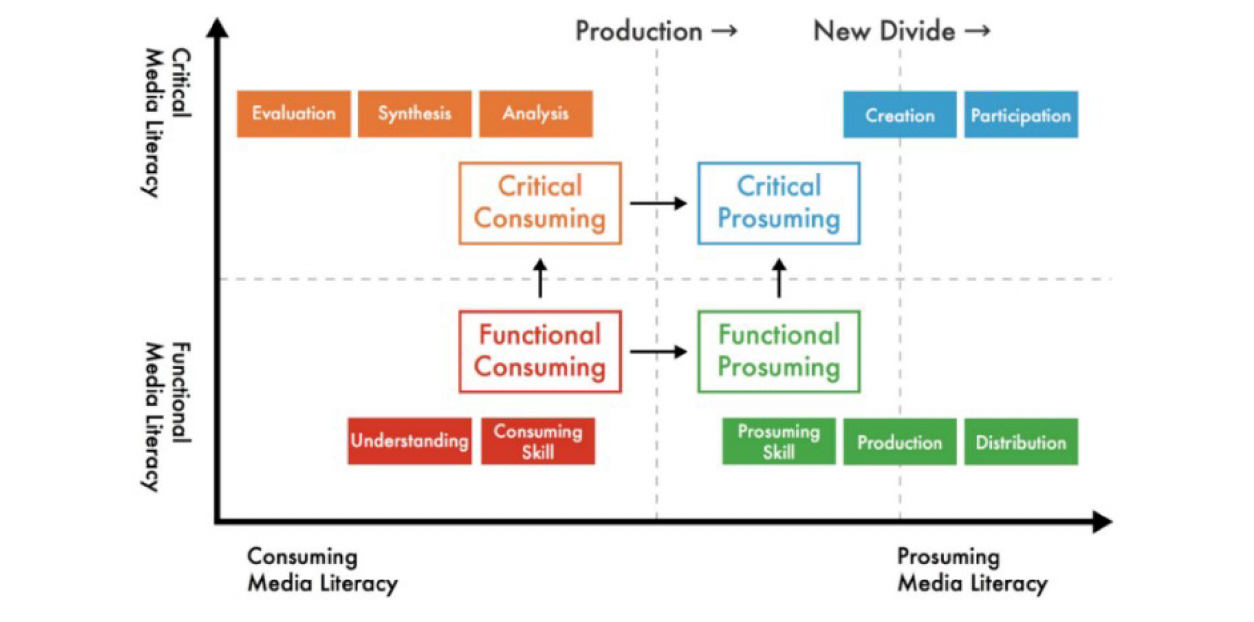
FIGURE 1 | New media literacy model (Lin et al.,